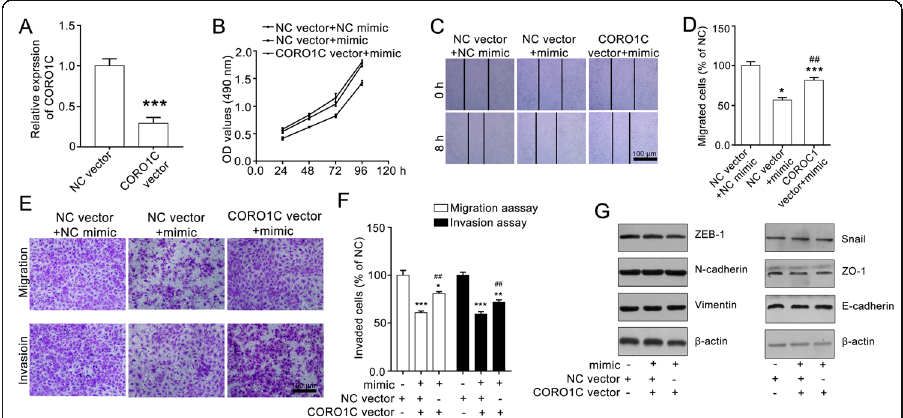
Fig. 4 CORO1C overexpression attenuates miR-206-mediated inhibitory effect on A549 cells. a CORO1C vector transfection increased CORO1C expression. The cells were treated with CORO1C vector or NC vector for 24 h, then the cells were collected for q-RT-PCR assay. b CORO1C vector transfection decreases miR-206- mediated inhibition effect on A549 cell proliferation. The cells were transfected with NC vector and CORO1C vector, and then treated with miR-206 mimic for 24 h. Then the cells were subjected to MTT assay. c and d ) CORO1C overexpression rescues miR-206-induced effect on the horizontal migration of A549 cells. A549 cells were transfected with NC vector or CORO1C vector, and then applied for wound healing assay stimulated with miR-206 mimic. Representative images (100× magnification) and the quantitative data are shown in c and d , respectively. ( e and f ) CORO1C vector attenuates miR-206-mediated inhibitory effect on the vertical migration and invasion of A549 cells. A549 cells were transfected with NC vector or CORO1C vector, and then subjected to transwell migration and transwell invasion assays. Representative images (100 × magnification) and the quantitative data are shown in e and f , representatively. g CORO1C vector rescues miR-206-induced inhibitory effect of EMT markers. The cells were transfected with CORO1C vector or NC vector. After 24 h the cells were collected and subjected to western blotting assay. Quantitative data are presented as mean ± SEM. *P < 0.05 and * **P < 0.001 compared with the NC vector group, # P < 0.05 and ## P < 0.01 compared with the NC vector+ NC mimic